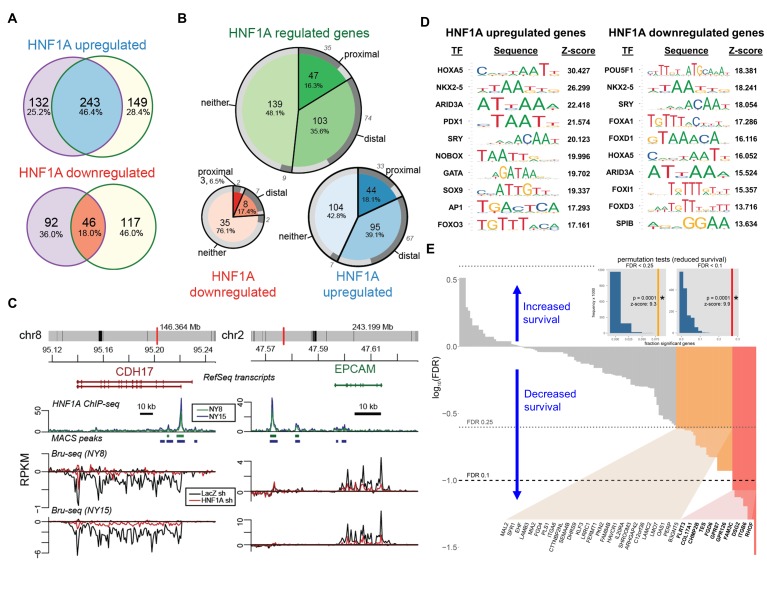
HNF1A regulates a transcriptional program associated with poor survival in PDA.(A) Venn diagrams illustrating overlapping genes with altered transcription (Bru-seq) following HNF1A knockdown in NY8 and NY15 cells. ‘HNF1A upregulated’ genes denote genes that were downregulated by HNF1A shRNAs, while ‘HNF1A downregulated’ genes were upregulated by HNF1A shRNAs. Cells expressed shRNAs constitutively for >14 days prior to Bru-seq analysis. (B) Proportion of HNF1A shRNA-downregulated genes identified in both NY8 and NY15 with HNF1A ChIP-seq peaks. Proximal peaks are ±5 kbp of the transcription start site (TSS) of a given gene and distal peaks are ±100 kbp of a TSS. Peaks are recognized only if they are closer to the TSS of a given gene than to other expressed genes. Peaks overlapping putative enhancer regions (ENCODE) are indicated in dark grey. (C) HNF1A ChIP-seq and HNF1A shRNA Bru-seq traces for the genes CDH17 and EPCAM in NY8 and NY15 cells. Traces represent normalized read coverage (in RPKM) across the indicated genomic ranges. MACS-identified ChIP peaks are represented by bars under the corresponding trace. (D) Transcription factor (TF) motif over-representation analysis of HNF1A upregulated and downregulated genes (±5 kbp of TSS). The top 10 over-represented TF motifs, ranked by z-score, are listed. (E) HNF1A upregulated and bound genes were ranked according to model significance and the direction of survival association using TCGA PDA patient data. Magnitude indicates significance (log10-transformed FDR-adjusted Wald p values for Cox PH models) and sign represents survival direction (determined by hazard ratio). Red bars indicate FDR < 0.1, orange bars indicate FDR < 0.25, and gray bars are not significant. The FDR thresholds are also indicated by dotted horizontal lines. Insets: each histogram represents the null distribution of a permutation test (N = 10,000) for fraction of genes significantly associated with reduced survival (the tests use FDR thresholds of 0.1 or 0.25, as indicated). Vertical lines represent values for the set of HNF1A target genes; red: FDR < 0.1 test; orange: FDR < 0.25 test. * - indicates significant p value estimates for the permutation tests. Related data found in Figure 7—figure supplement 1.